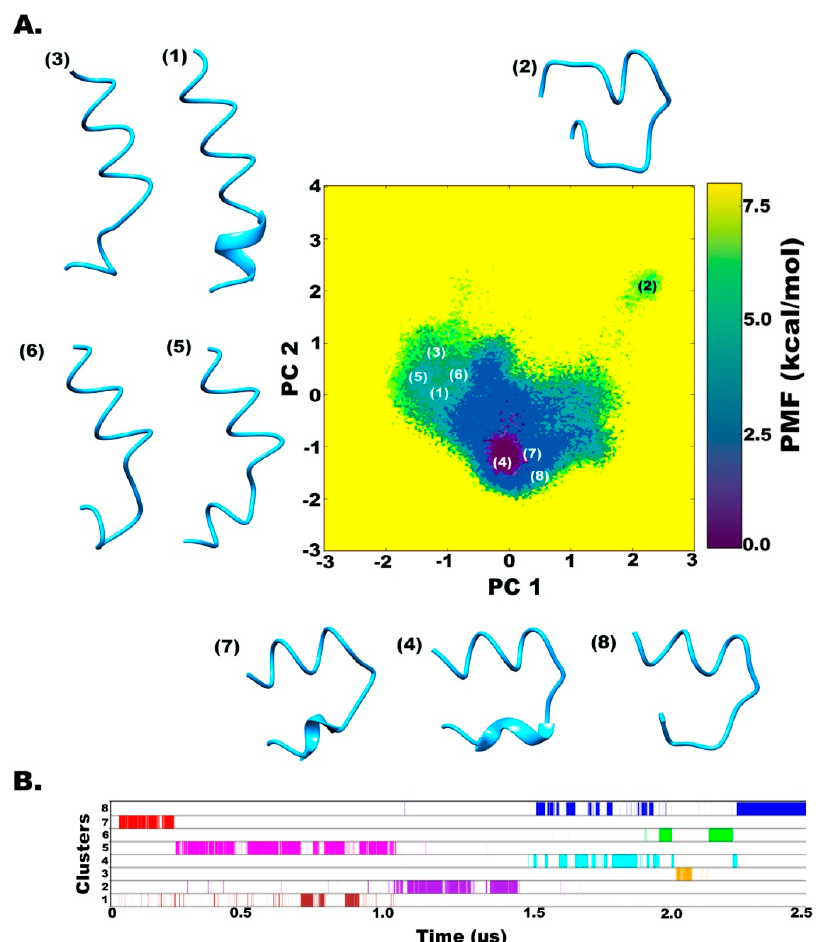
Figure 4. ( A ) Reweighted free energy landscape of the first two principal components calculated from dihedral angles, phi-psi, for better clustering based on internal motions. ( B ) Diagrammatic representation of cluster distribution along the simulation trajectory in chloroform.